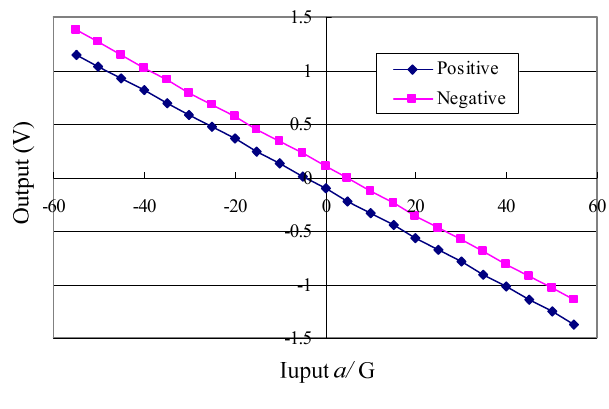
Figure 3. Data of experiments on the selected sensor.